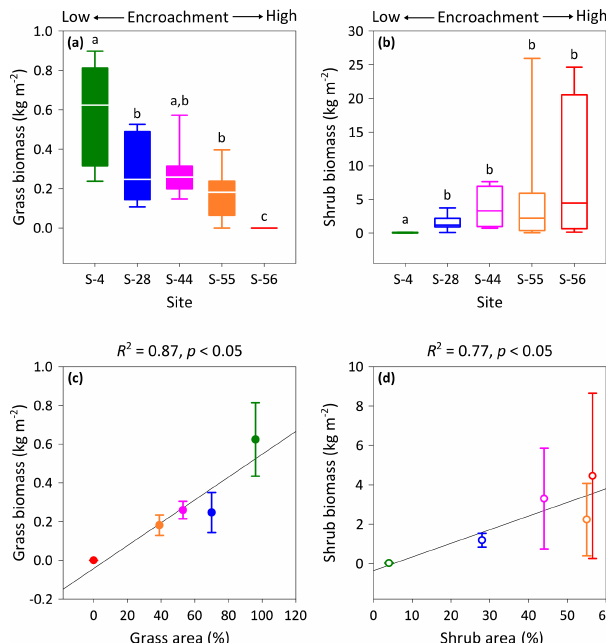
Figure 4. Above-ground multispecies grass (a) and Prosopis ve- lutina Woot. (b) biomass by dry weight across a shrub encroach- ment gradient and according to grass (c) and shrub (d) cover in the Santa Rita Experimental Range, AZ, US ( n = 9). Boxes denoted with different letters indicate significant differences within biomass classes at p <0.05 (Dunn’s test). Error bars represent median abso- lute deviation about the